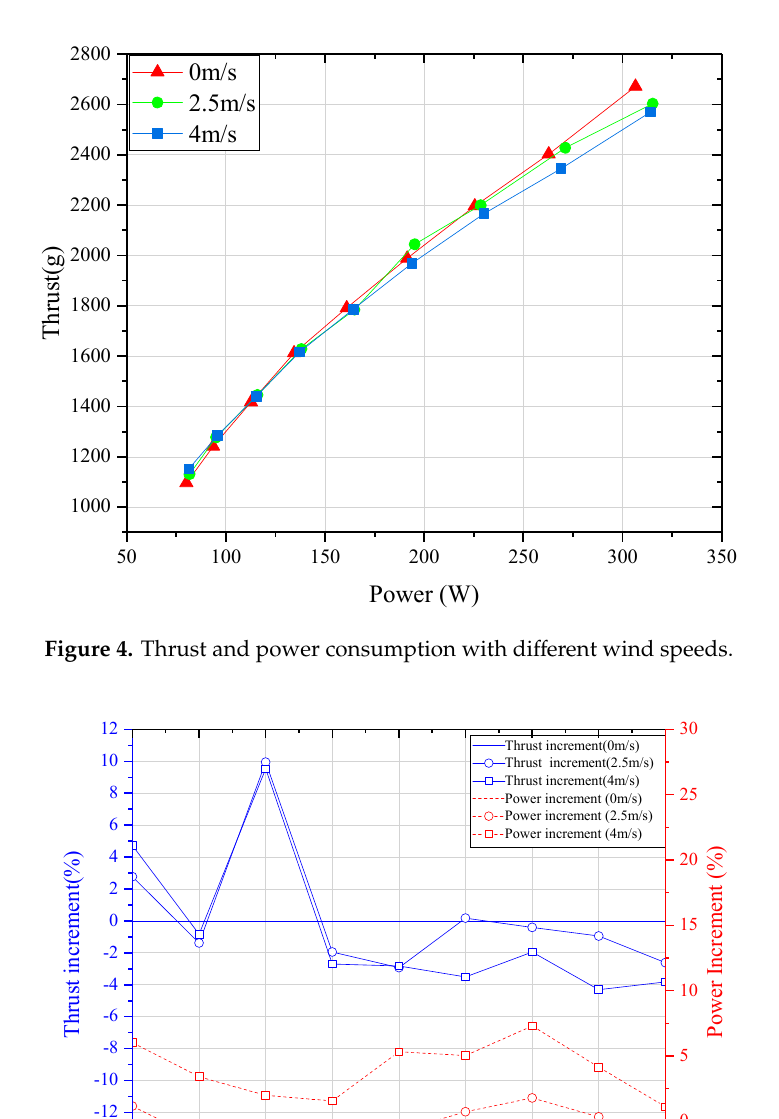
Figure 5. Thrust and power increment at different speeds.